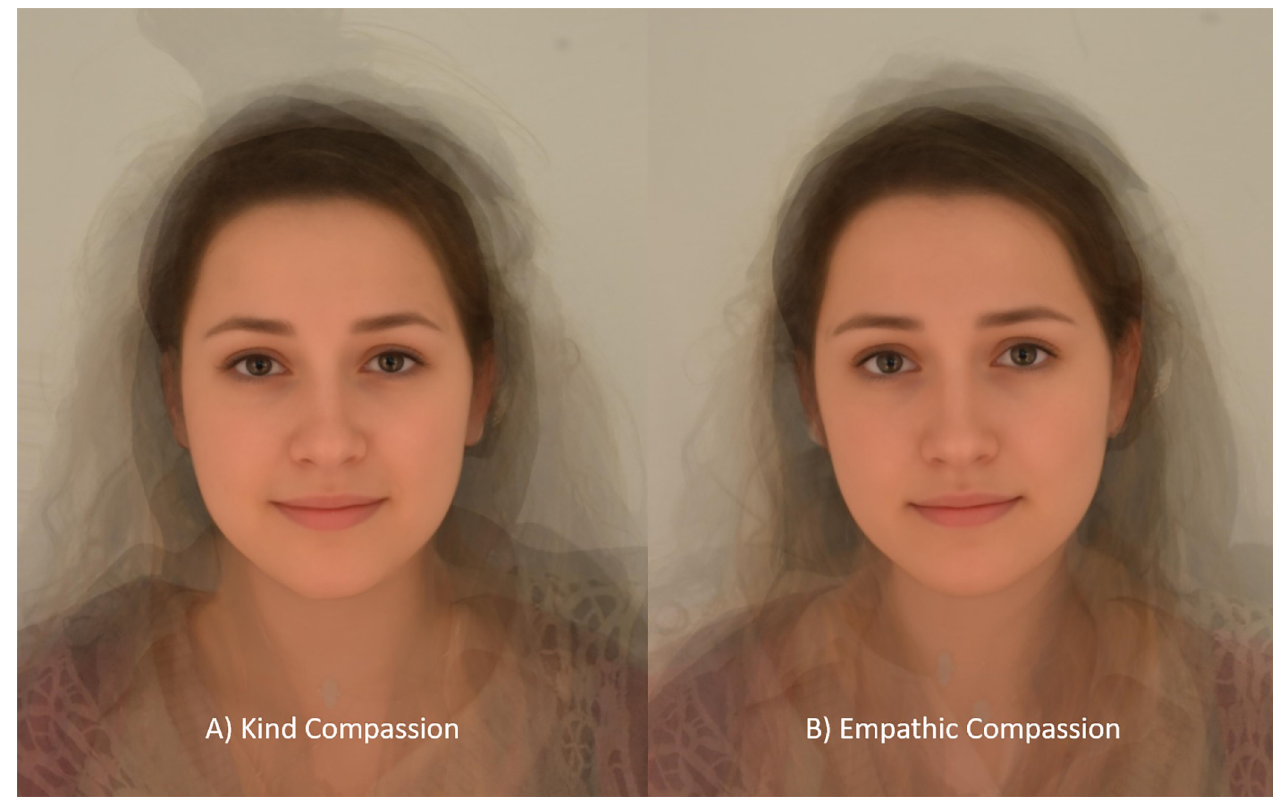
Fig 1. Prototypes of Kind (A) and Empathic (B) Compassion. The composite images are averages of the 10 faces that received the highest compassion